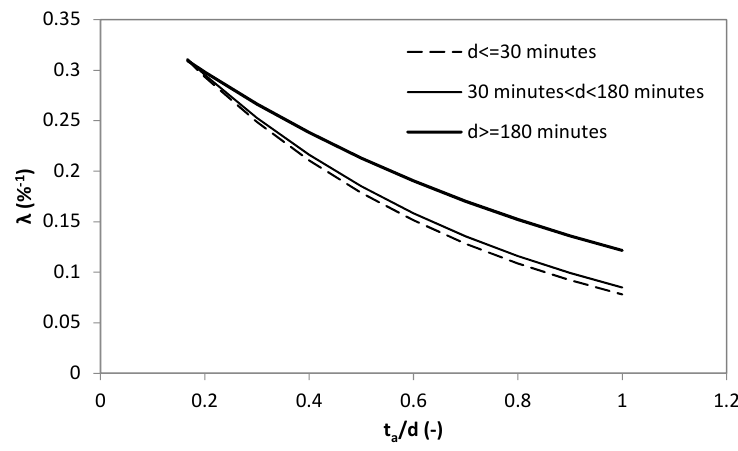
Figure 8. Behavior of the λ parameter obtained by Equations (6)–(8) depending on ratio t a / d where t a is the time resolution of rainfall data and d is the duration.